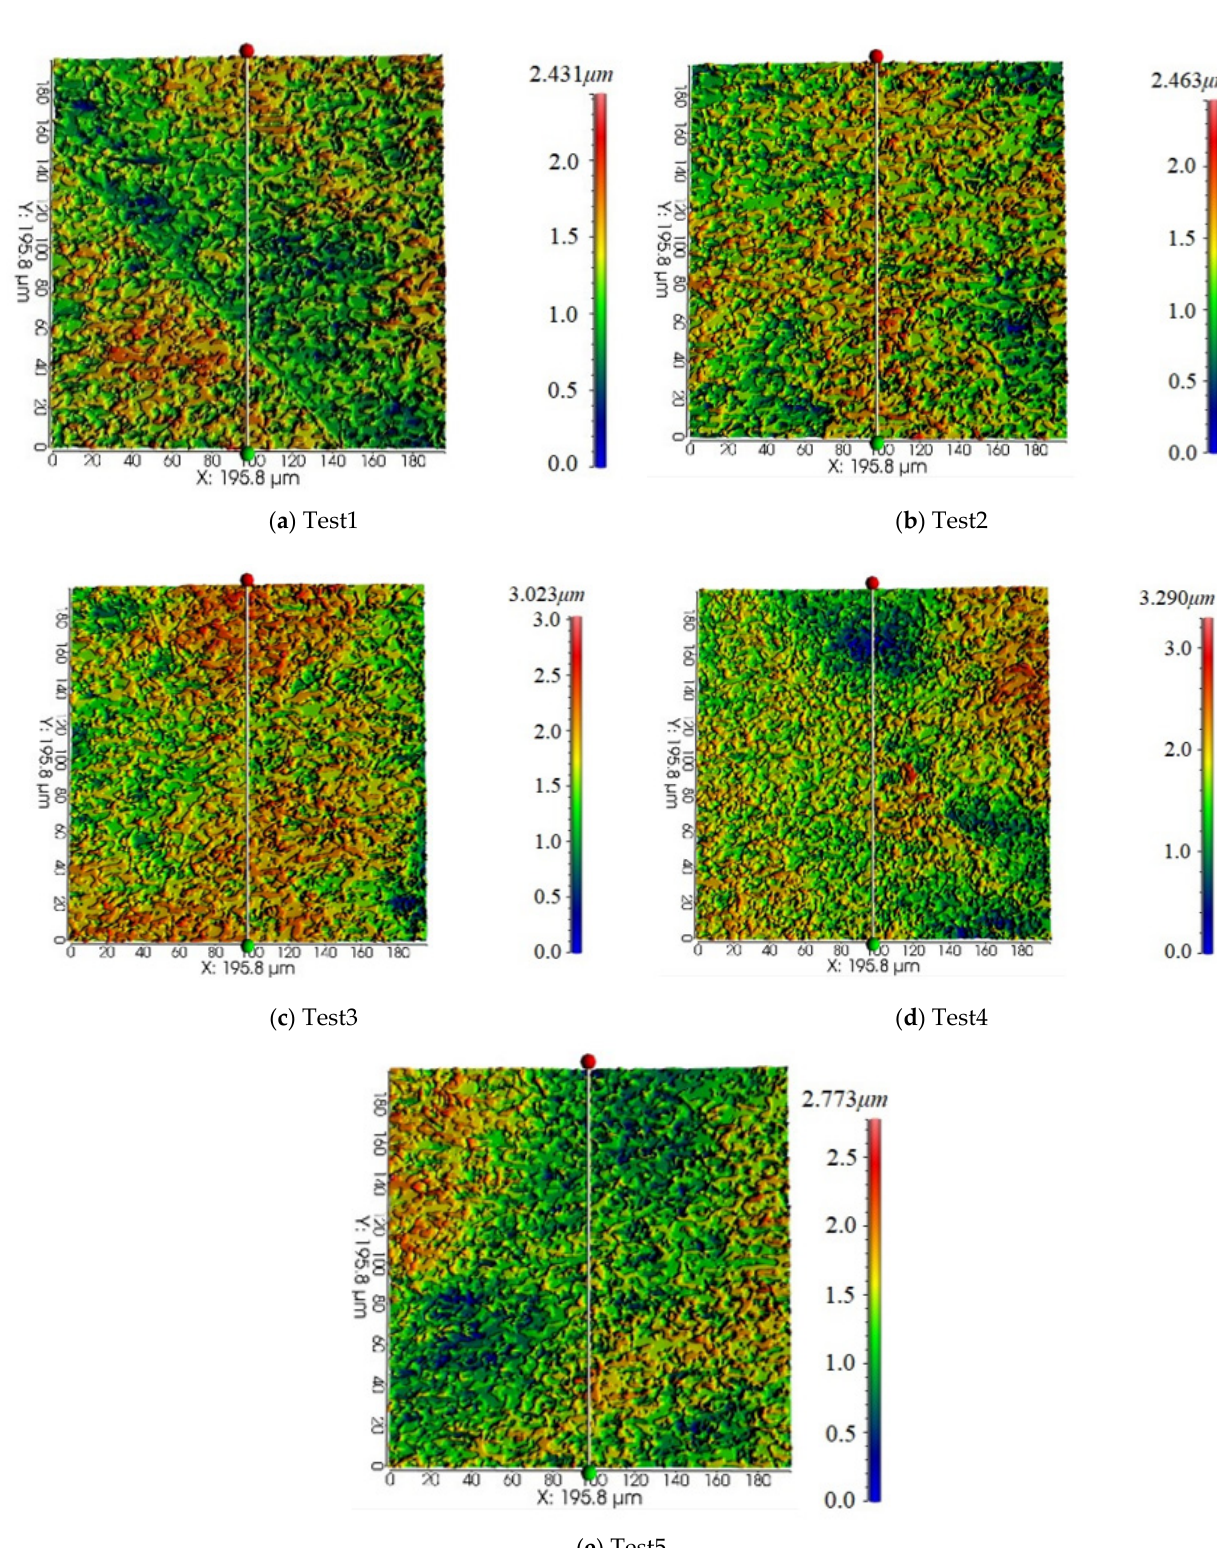
Figure 7. ( a – e ) Surface roughness measurement of guide vane.